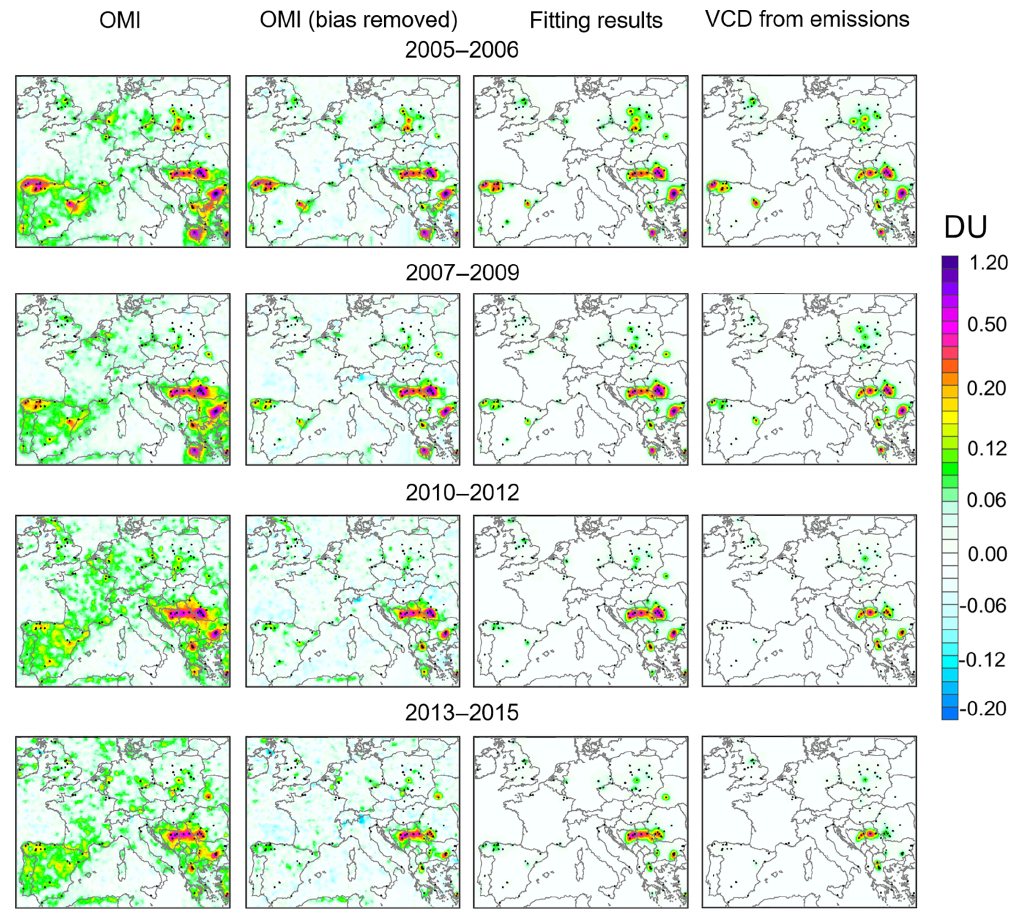
Figure 5. The same as Fig. 1, columns I–IV, but for the part of Europe where the majority of SO 2 point sources are located. Point sources that emitted 10ktyr − 1 at least once in the period 2005–2014 were included in the fit (they are shown as the black dots). High SO 2 values related to the Mt. Etna volcano in Sicily are excluded from the OMI plots. The area 35.6 to 56.6 ◦ N and 10 ◦ W to 28.4 ◦ E is